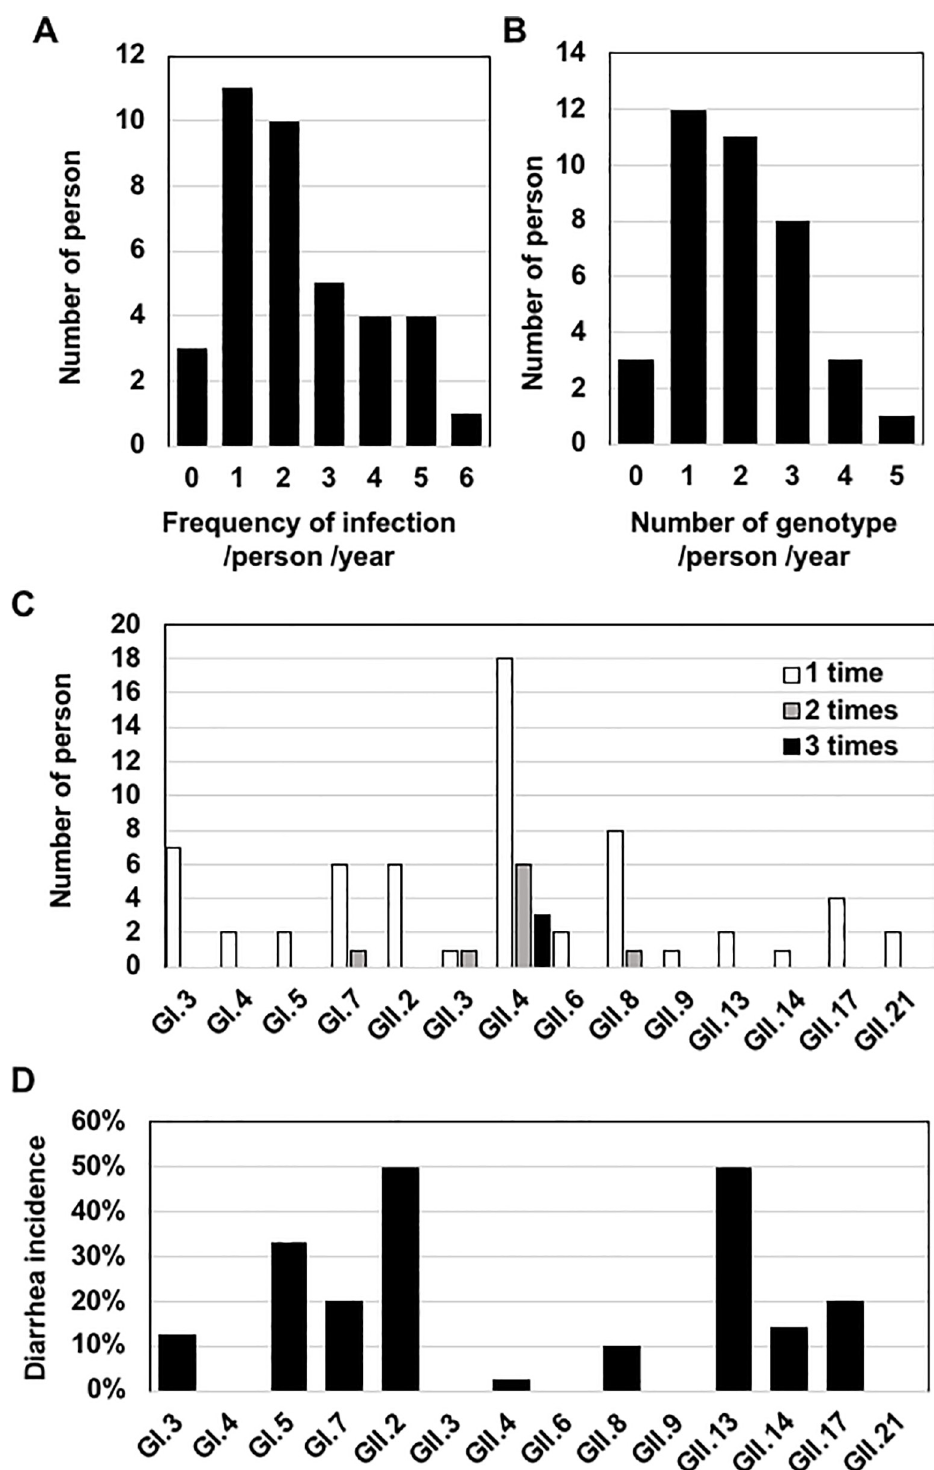
Fig 4. The NV infection frequency and the number of genotypes for each individual. ( A) The frequency of NV infection. Infections of the same genotype that occurred more than 1-month interval were counted as 2 independent infections. When the same genotype was detected in consecutive periods, it was counted as one infection. Co-infection with 2 distinct genotypes during the same period was counted as 2 independent infections. The y-axis indicates